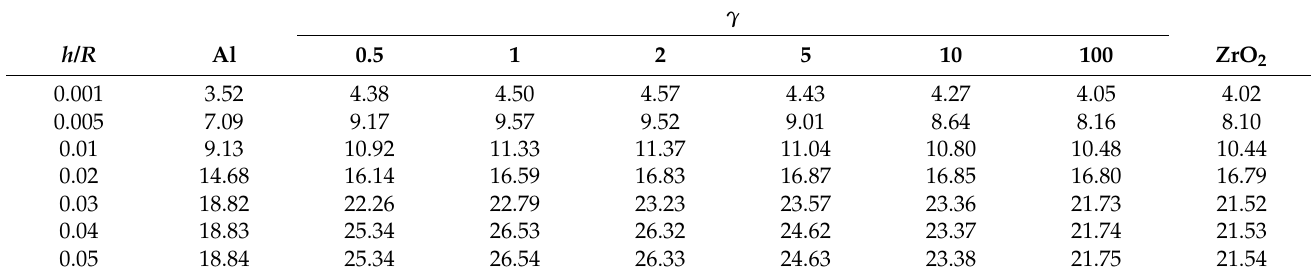
Table 5. Variations of the fundamental frequencies (Hz) with the power-law exponent and thickness to radius ratio ( h / R ).